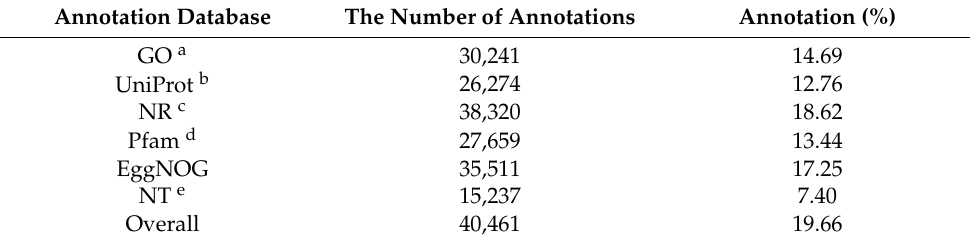
Table 3. Summary data of the annotation using various databases in T . koraiensis .